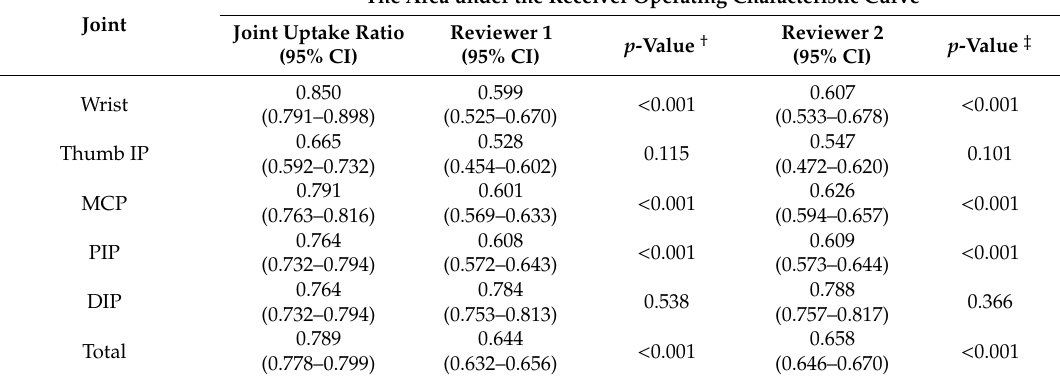
Table 2. Comparisons of the area under the receiver operating characteristic curve values between the joint uptake ratio and the visual analysis results of two readers.